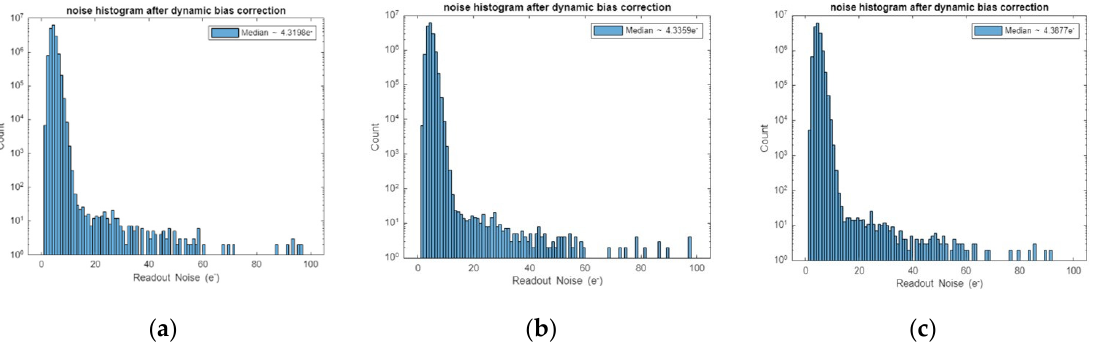
Figure 16. The readout noise test result of the camera. ( a ) 28 June 2022 test result; ( b ) 6 July 2022 test result; ( c ) 19 July 2022 test result.